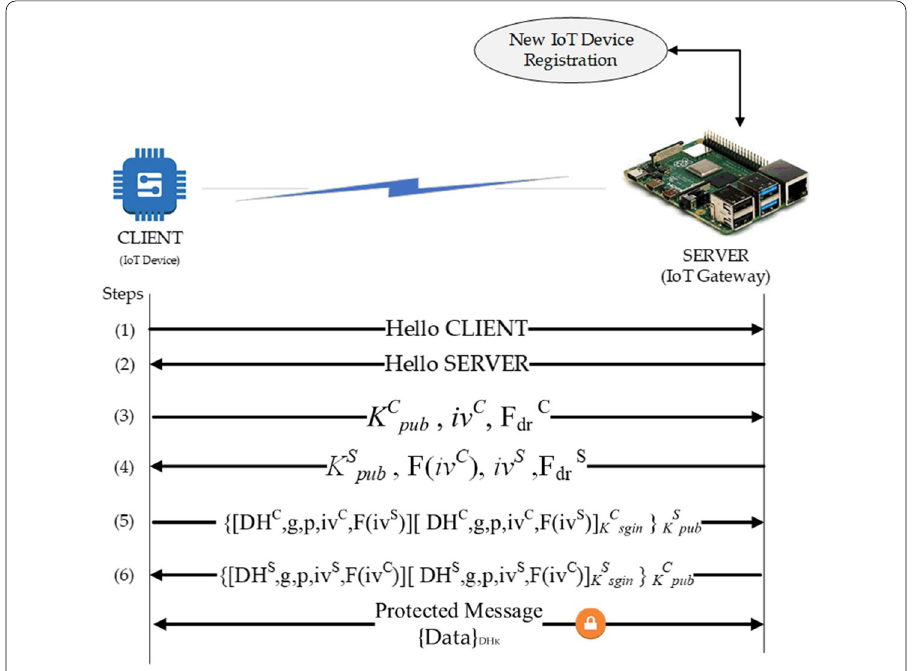
Fig. 4 Local mutual authentication procedure at IoT edge computing